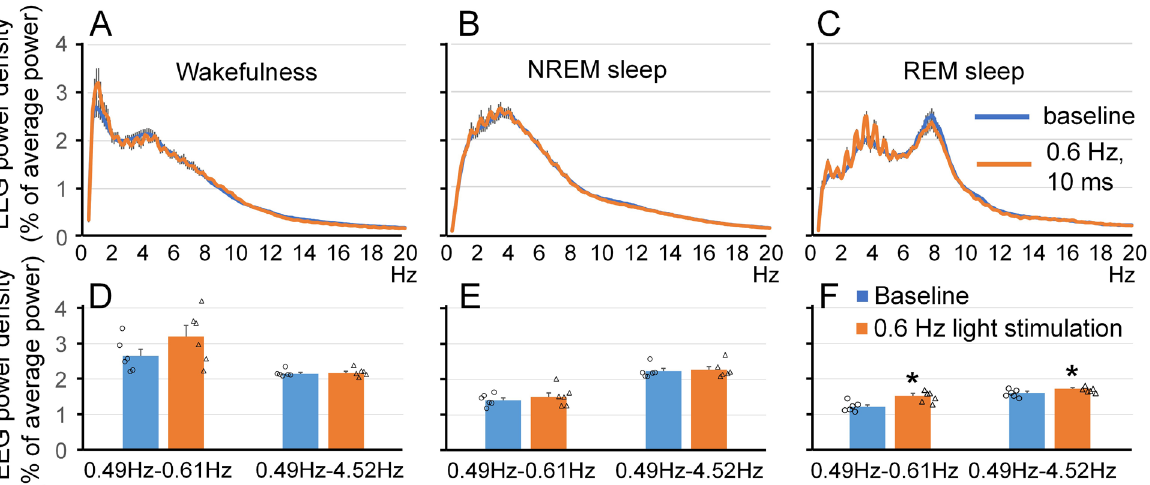
Figure 4. Effect of visual stimulation with 10-ms 620-nm light pulses at 0.6 Hz on EEG power spectrum. The profile of spectral power over 24 h was compared between the baseline day and the next day during which the visual stimulation was performed. The profile of spectral power in mice stimulated with 400-ms light pulses during wakefulness ( A ), NREM sleep ( B ) and REM sleep ( C ) is similar to that observed in the mice stimulated with 400-ms light pulses (Fig. 2), except that the amplitude of both the fundamental frequency and harmonics is lower. EEG power in the stimulation frequency range (0.49–0.61 Hz) and delta frequency range (0.49–4.52 Hz) were not statistically different between baseline and in the process of the light stimulation during wakefulness ( D ) and NREM sleep ( E ) but was higher during REM sleep ( F ). * p < 0.05.